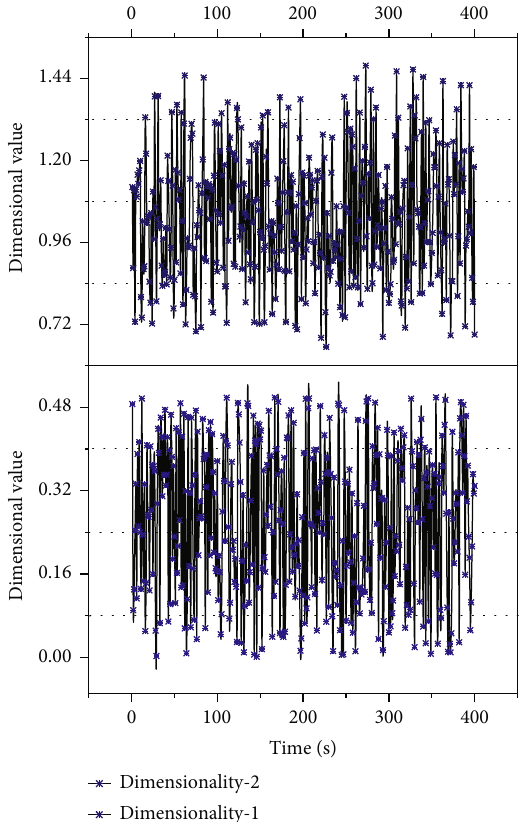
Figure 5: Signi fi cance of each dimension of the timbre-spectrum